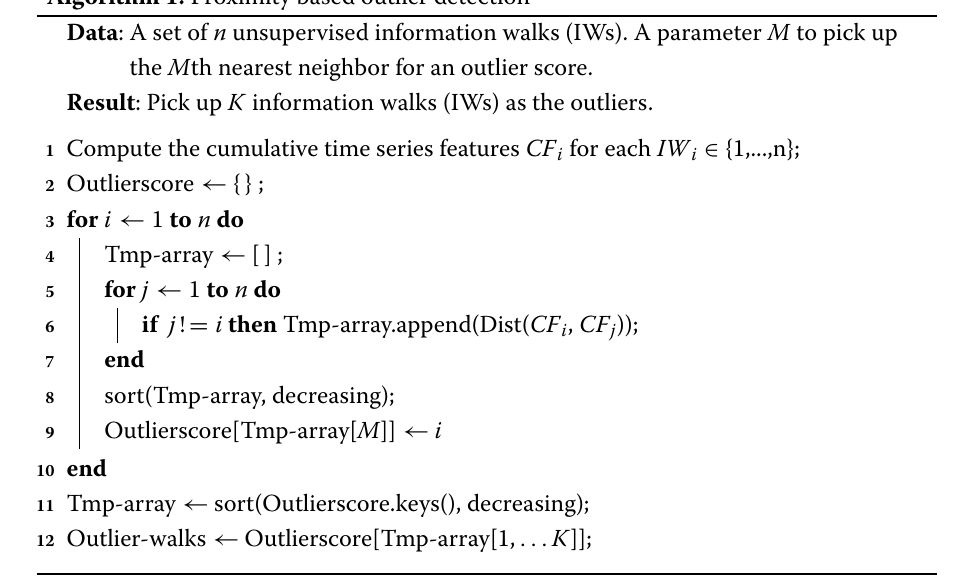
Algorithm 1: Proximity based outlier